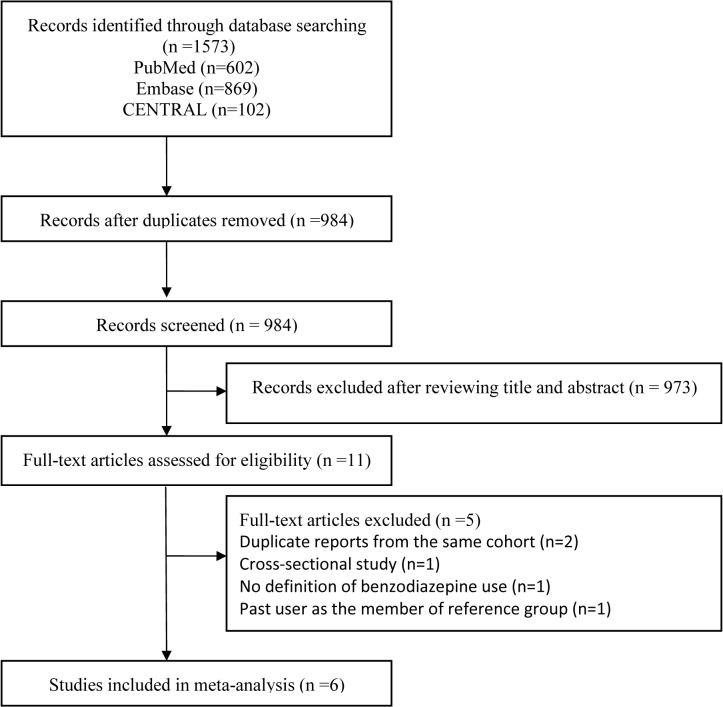
The flowchart of identifying relevant studies.